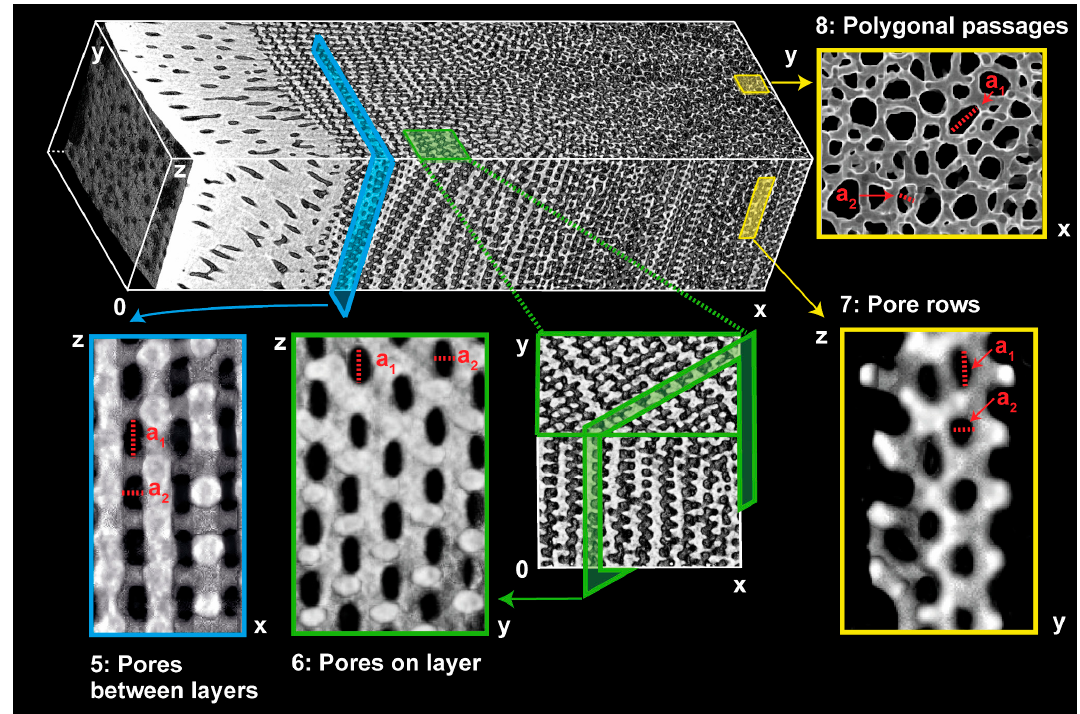
Figure 7. A stacked µCT reconstruction of the inner microstructure of the spine of Phyllacanthus imperialis . The turquoise and green boxes visualize different cross-sectional planes of the structure of the radiating layer. The inner mesh of the center of the spine is shown in the yellow boxes (polygonal passages, pore rows). The largest and the smallest pore diameter are indicated by a 1 and a 2 , respectively.